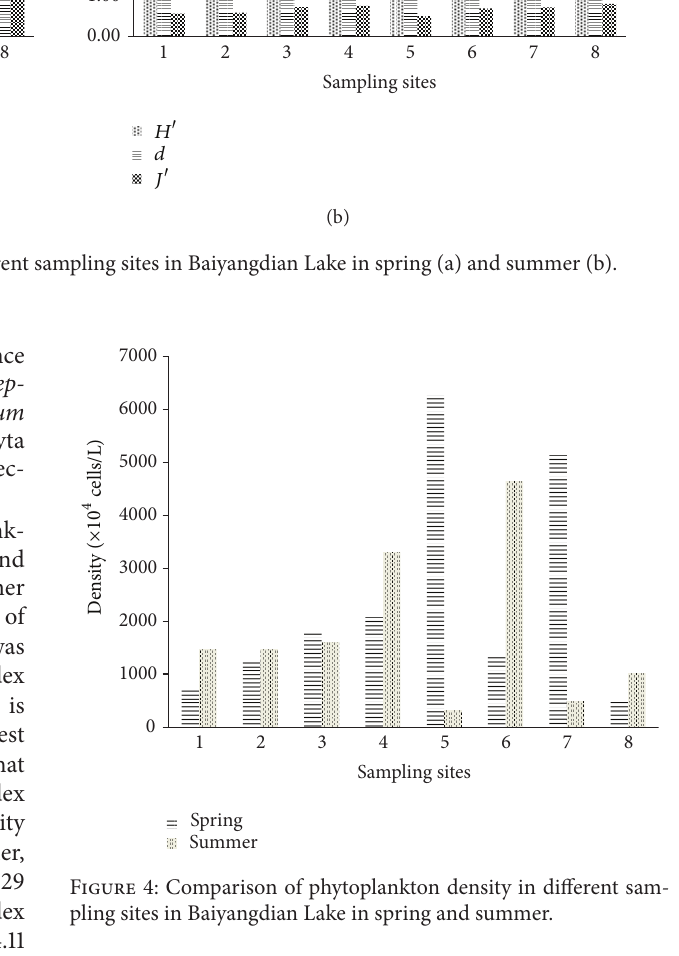
Figure 4: Comparison of phytoplankton density in different sam- pling sites in Baiyangdian Lake in spring and